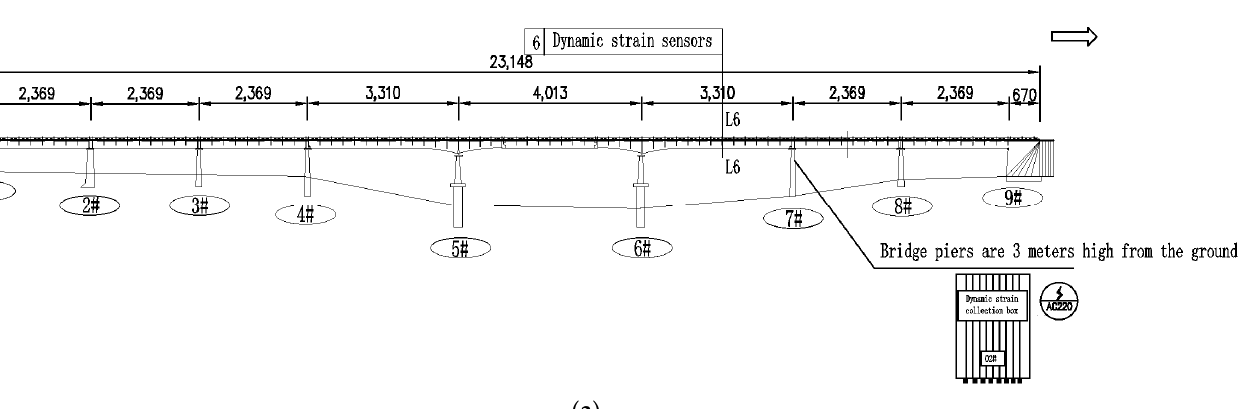
Figure 12. ( a , b ) Diagram of the sensor arrangement; ( c ) resistive surface strain gauge. The strain sensor system for the bridge adopts resistive surface strain gauges, and the sensors are installed at the bottom of the girder by surface-mounting. The concrete surface is polished and de-dusted before installation to ensure the stability of the sensor. During the operation of the sensor, the vehicle passes over the cross section of the sensor arrangement on the bridge deck, and the sensor records the structural response to generate an electrical signal, which is converted into a dynamic strain signal through the on-site strain-gathering box around the clock and then transferred to the workstation computer database for extraction and analysis in real time through the cable (Figure 13).